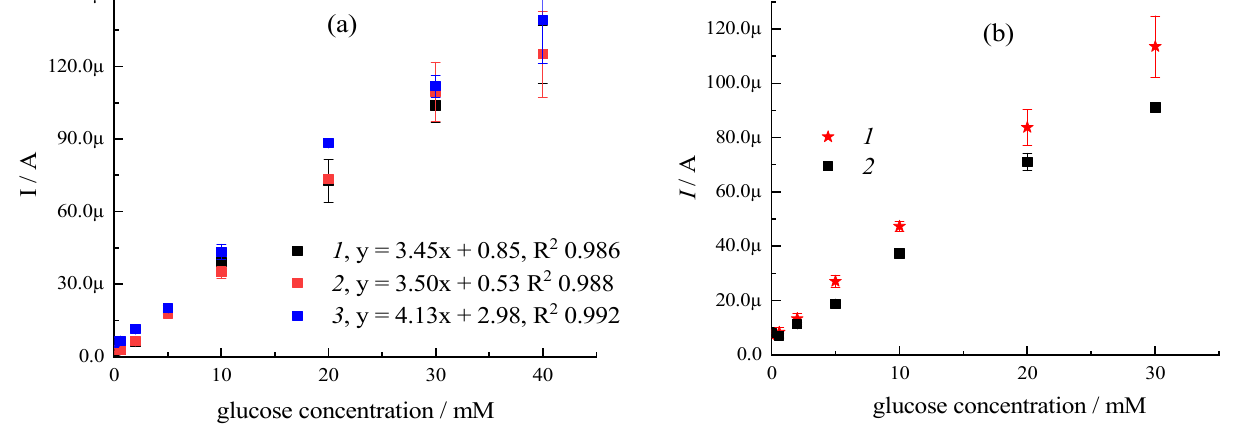
Figure 4. Calibration curves obtained from glucose test-strips modified by ( a ) fresh 10CMC/25ALG/200FC/12GOx gel in citrate buffer, pH 6 (1), the same gel after 2 h of storage in dark (2) and after 2 h of controlled UV irradiation at 19 W (3); ( b ) fresh 10CMC/25ALG/200FC/24GOx gel in citrate buffer, pH 6 (1), and the gel with the same content of bioorganic compounds (10CMC/25ALG/24GOx) but different ratio and nature of RedOx mediator, i.e., 198 mg/mL of ferricyanide (FC) and 2 mg/mL of ferrocyanide (2). Notably, the replacement of 2 mg/mL of RedOx mediator FC in the fresh 10CMC/25ALG/ 200FC/24GOX (CitB) gel by only 2 mg/mL of ferrocyanide led to a pronounced current